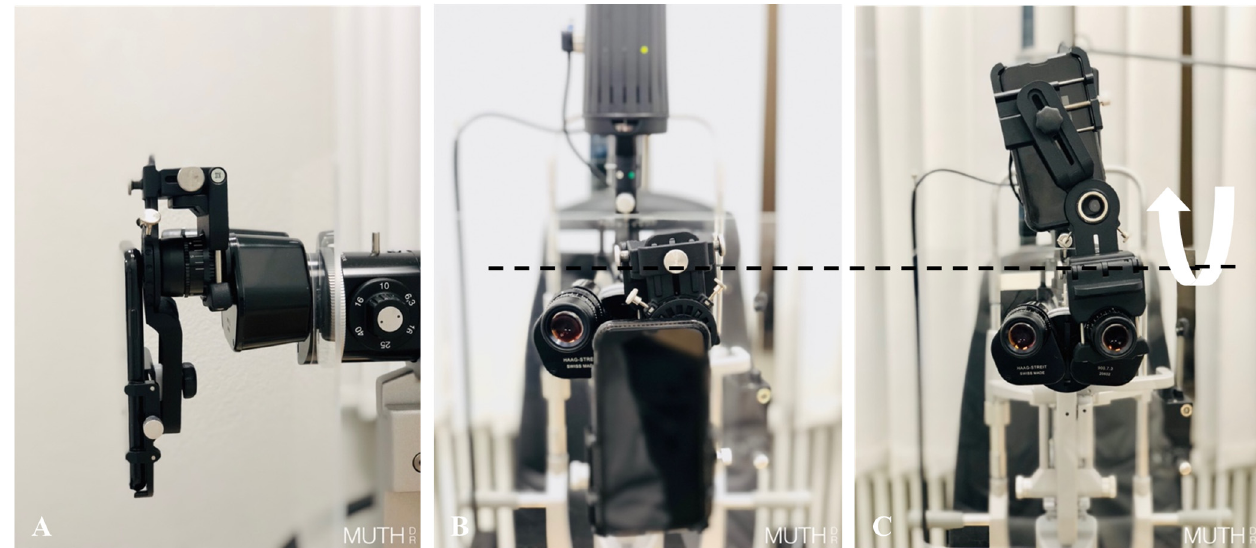
Figure 2. Smartphone mounted on a slit lamp via Custom Surgical SlitREC adapters: ( A ) adapter flipped down (capture mode), side view; ( B ) adapter flipped down (capture mode), front view; and ( C ) adapter flipped up (clinical mode) with a smartphone (held by magnets only), front view.